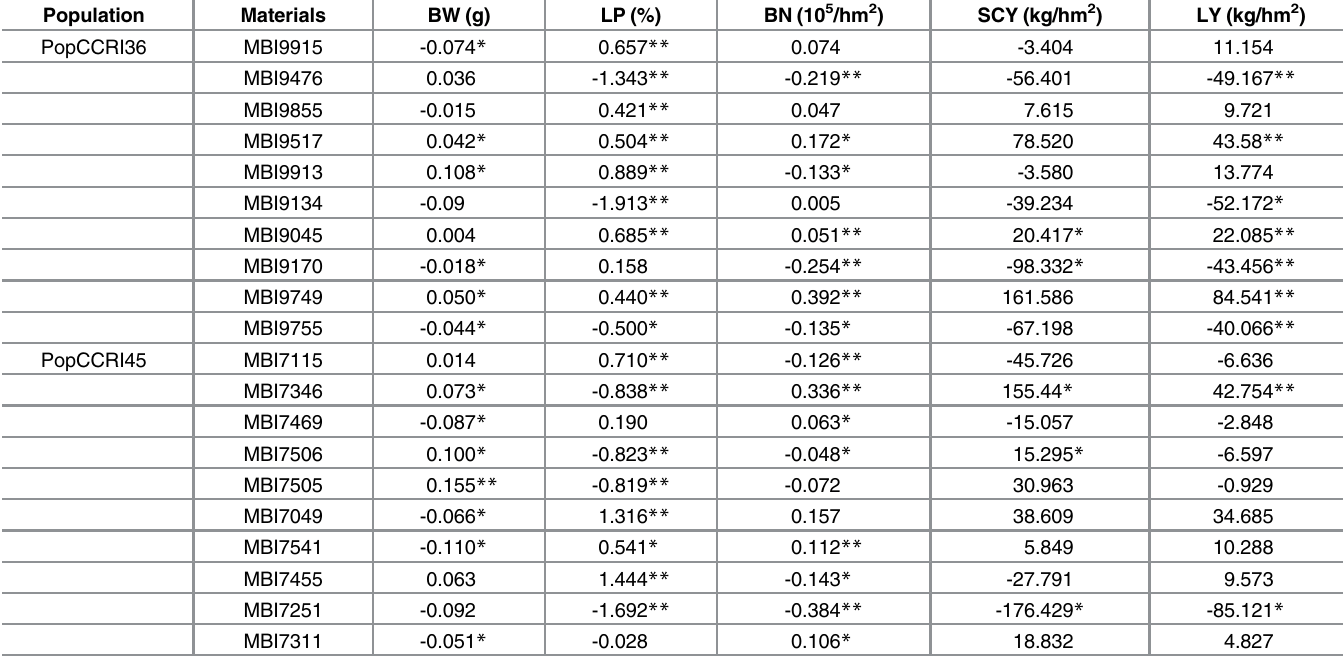
Table 3. Predicted values of additive effects for